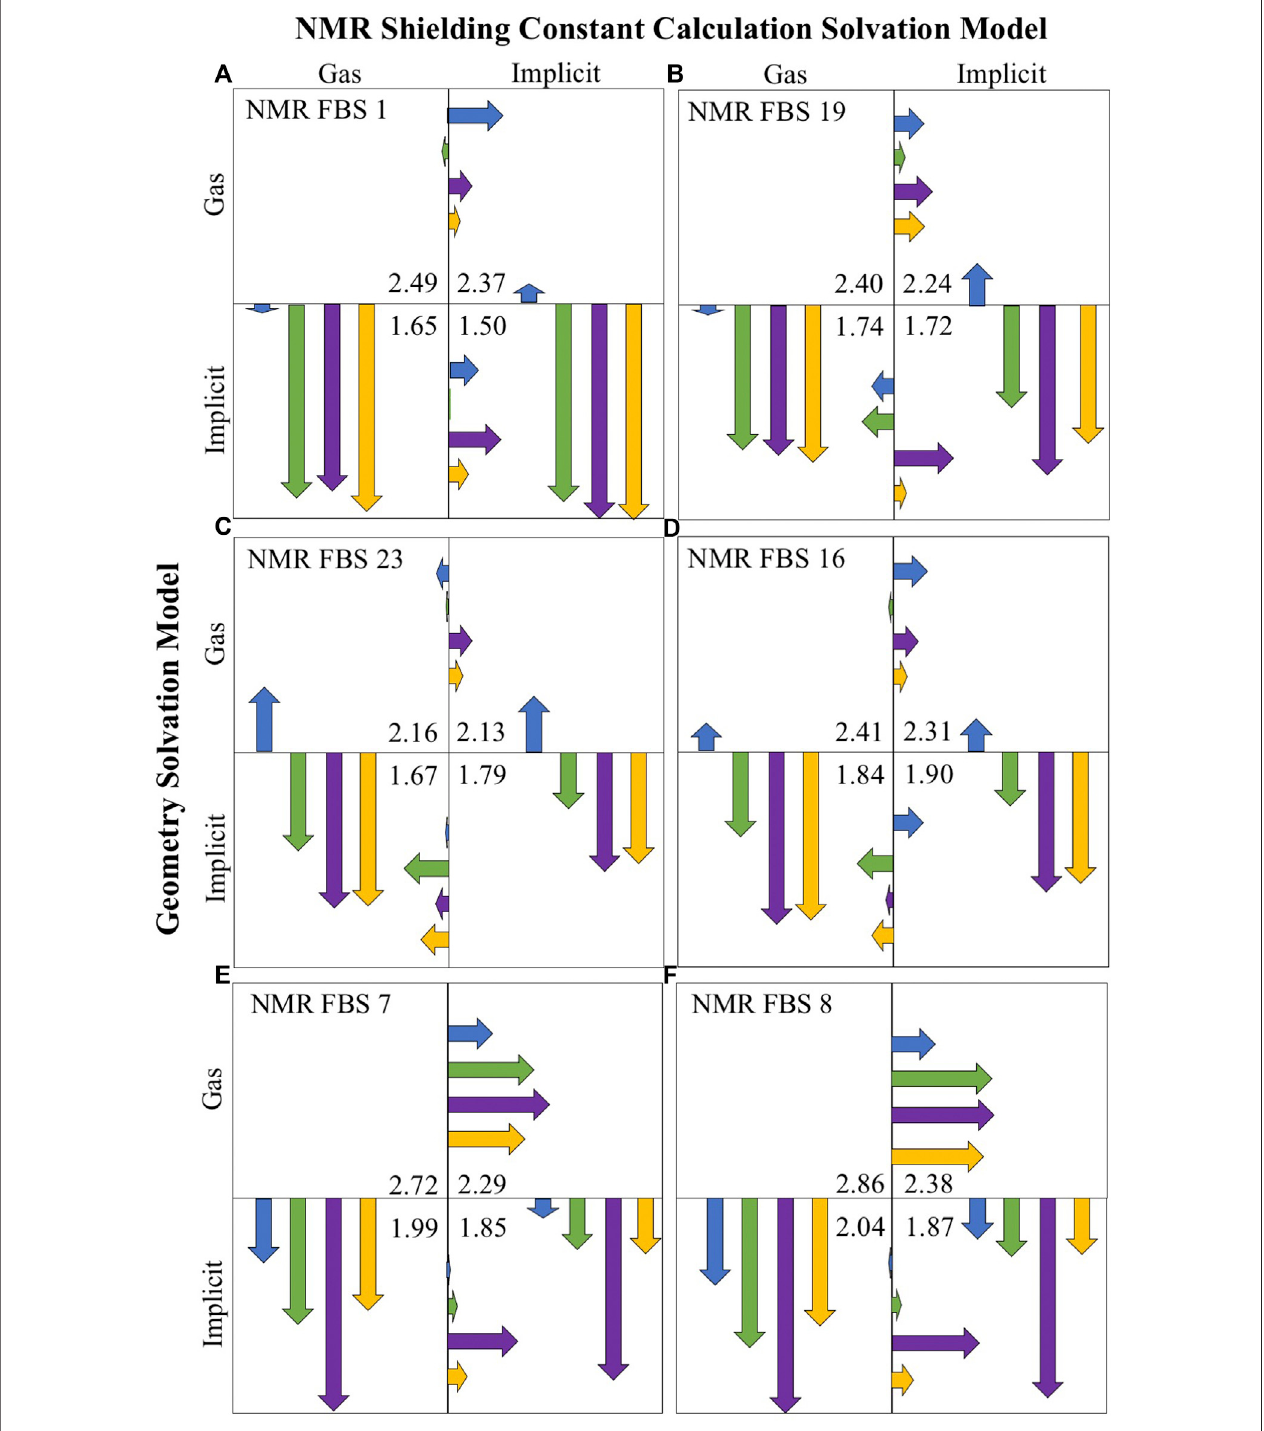
FIGURE6| Meanabsoluteerror(MAE)improvementsuponsolvationforthetop-performingnuclearmagneticresonance(NMR)functional – basissets(FBS):1 (A) , 19 (B) ,23 (C) ,16 (D) ,7 (E) ,and8 (F) .Arrowsarecolor-codedaccordingtothecompoundnumber.VerticalarrowsindicateMAEimprovementsduetotheconsideration of solvation during the geometry optimization, while horizontal arrows signify improvements during shielding constant calculations. The arrows point into the quadrant showing the most improvement. The listed MAE values (ppm) are the average of all compounds for that solvent combination. Their size indicates the size of MAE improvement upon a change in solvation model, where the full-length of a box is equal to an MAE improving by 1.23 ppm.